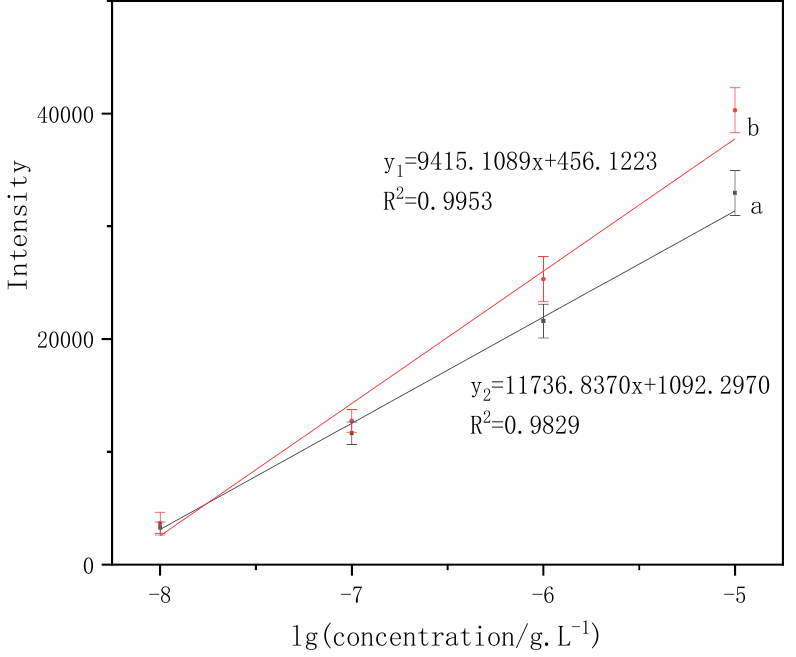
Figure 9. Linear relationships between the phenanthrene characteristic intensity and the logarithm of phenanthrene concentration. (a) 590 cm − 1 ; (b) 411 cm − 1 .